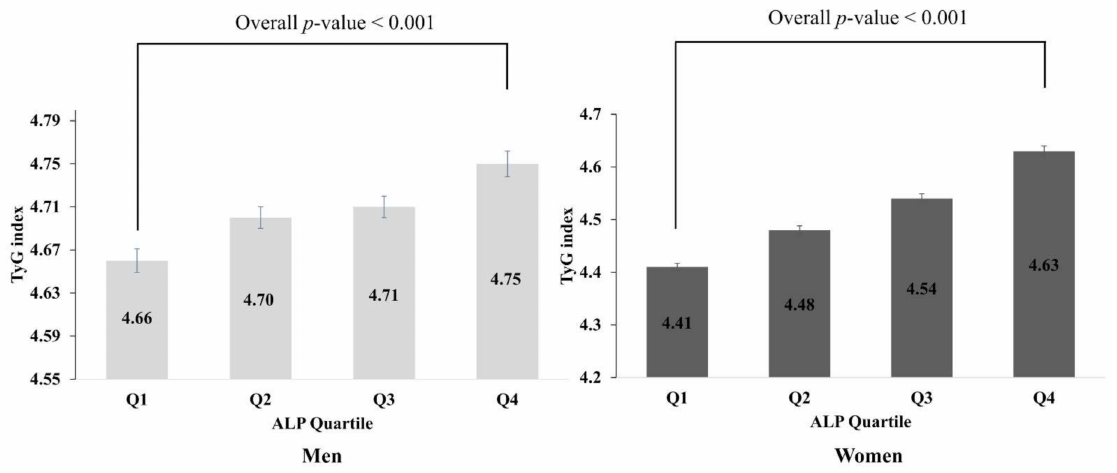
Figure 3. Trend analysis of TyG index according to ALP quartile. Values are assessed by ANOVA. The ORs (95% CIs) for high TyG index according to serum ALP quartile are